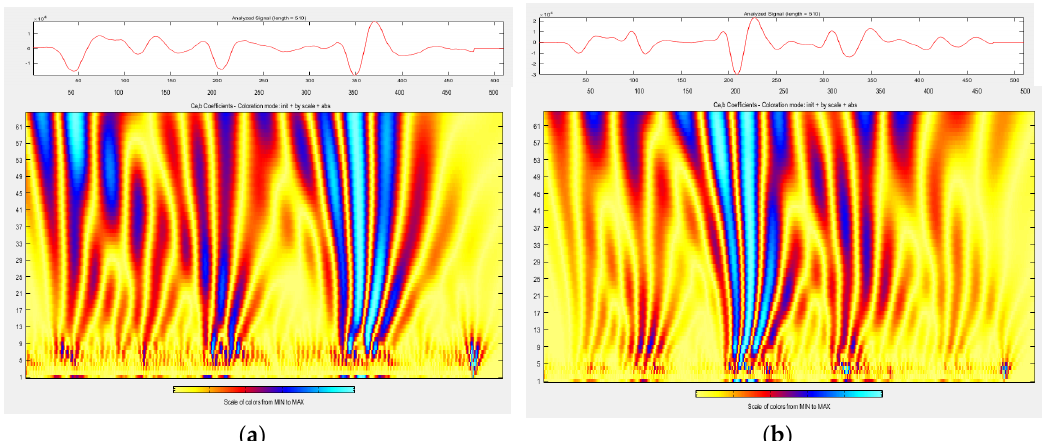
Figure 8. Wavelet analysis of A-scan from measurements in conditions ( a ) wI (temp. 28 °C, dry slab surface); ( b ) wII (temp. − 5 °C, dry slab surface).